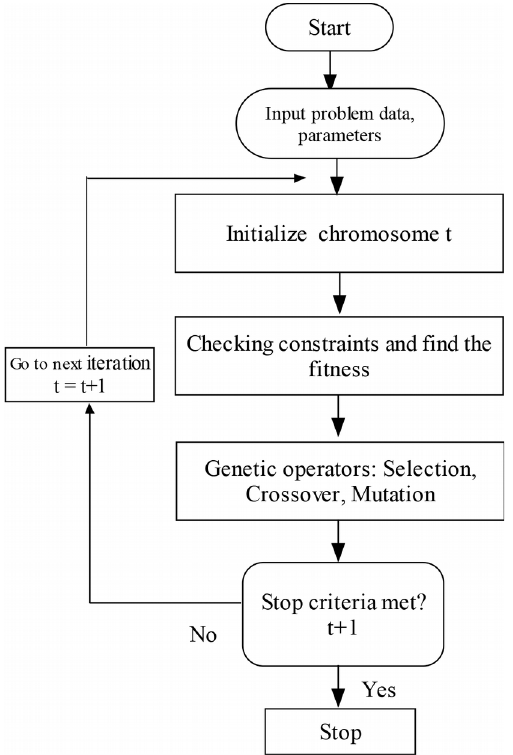
Figure 1. The process of fuzzy simulation-based genetic